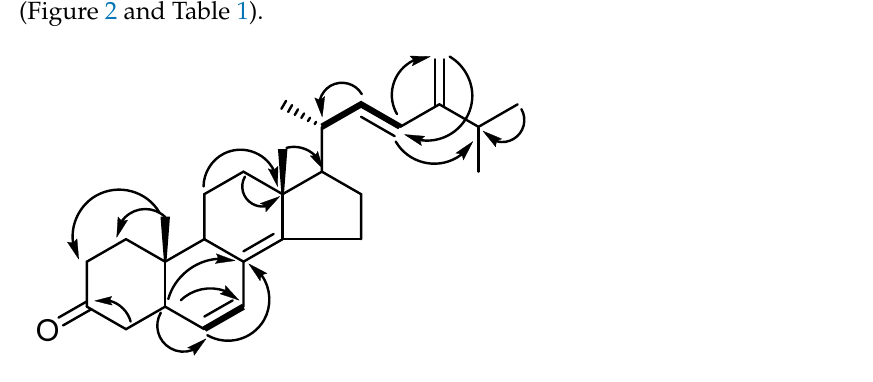
Figure 2. 1 H, 1 H-COSY (—) and key HMBC (H C) correlations of compound 1 (TNS).